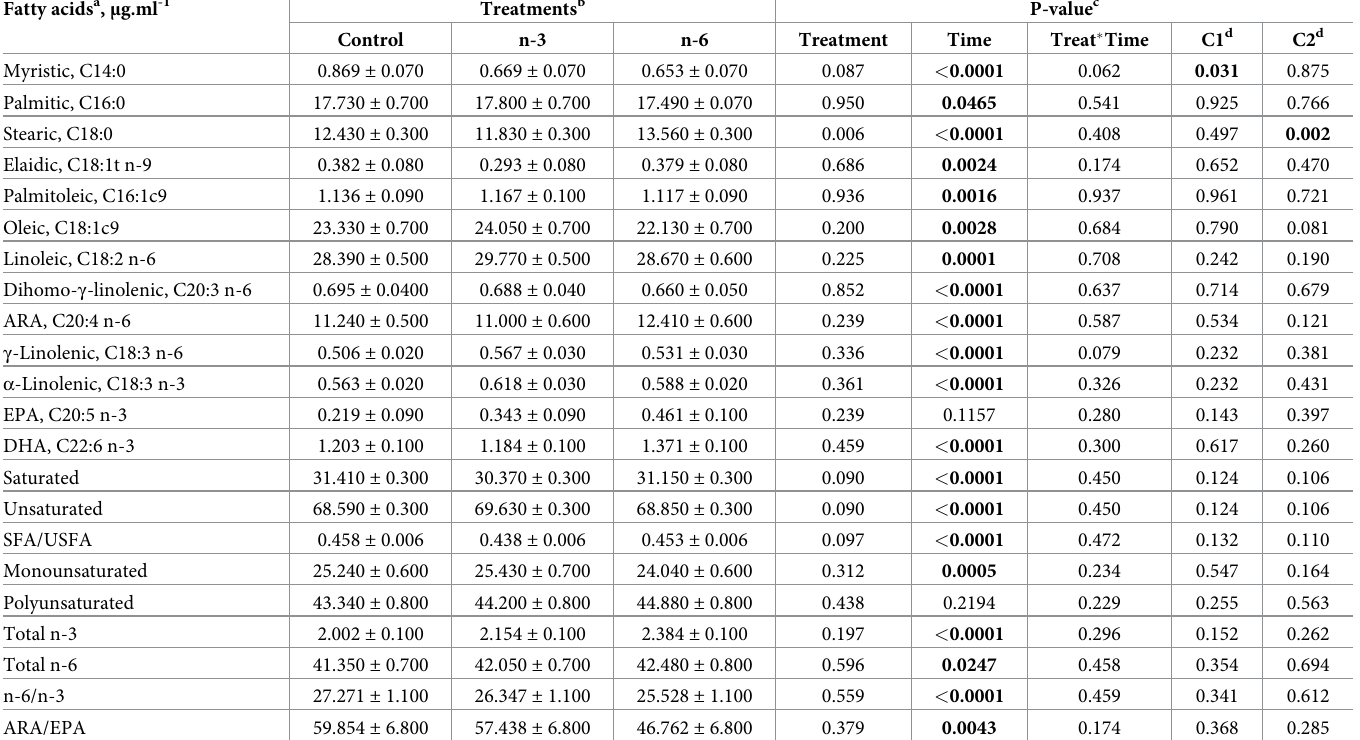
Table 4. Effect of supplementation of milk enriched with n-3 and n-6 on serum fatty acids profile of gilts from 34 to 190 days of age. Fatty acids a , μ g.ml